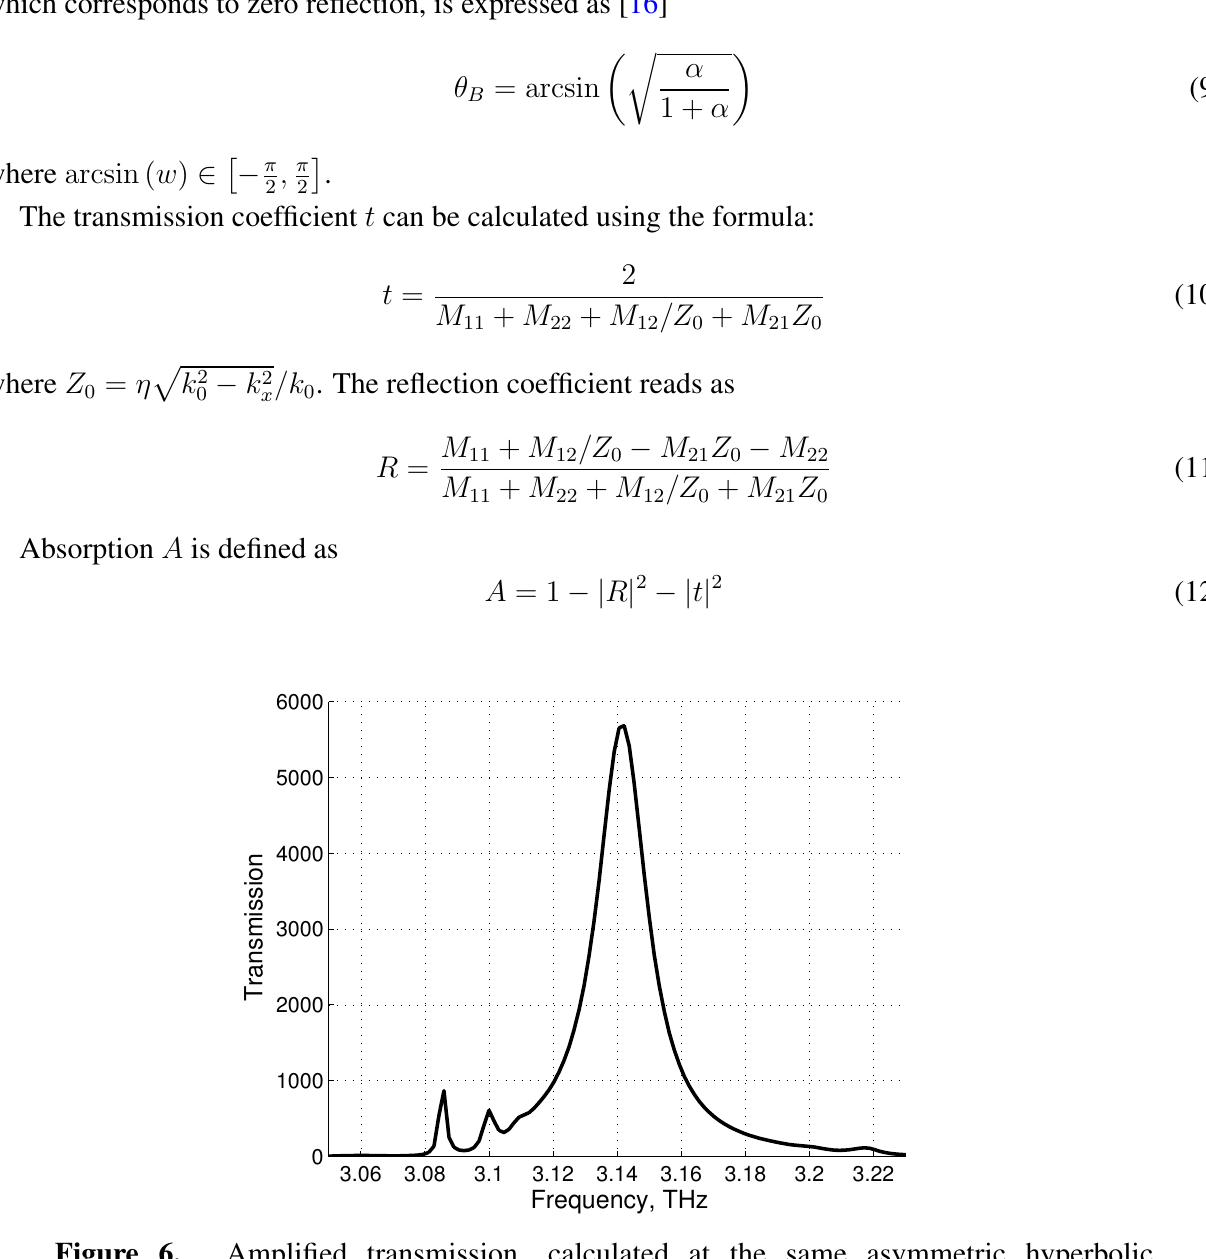
Figure 6. Amplified transmission, calculated at the same asymmetric hyperbolic metamaterials (AHMM) parameters as above. The thickness of the graphene-based AHMM slab h = 10 µ